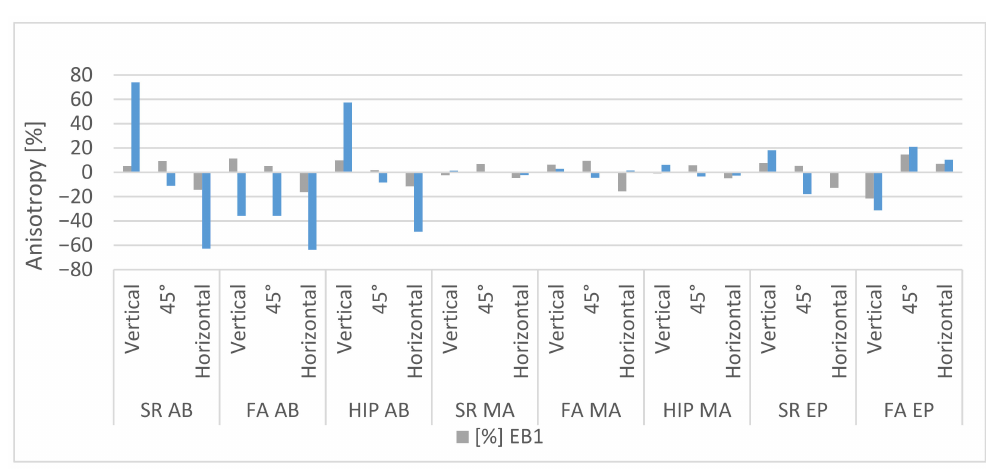
Figure 9. Directional anisotropy—elongation at break and constriction.